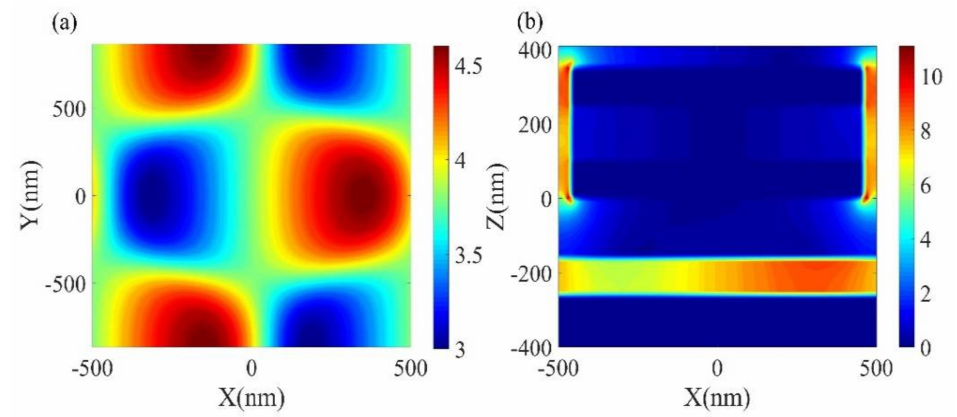
Figure 8. ( a ) Electric field distribution in the x-y plane with a resonance peak of 11 µ m at an incident angle of 30 ◦ . ( b ) Electric field distribution in the x-z plane with a resonance peak of 11 µ m at an incident angle of 30 ◦